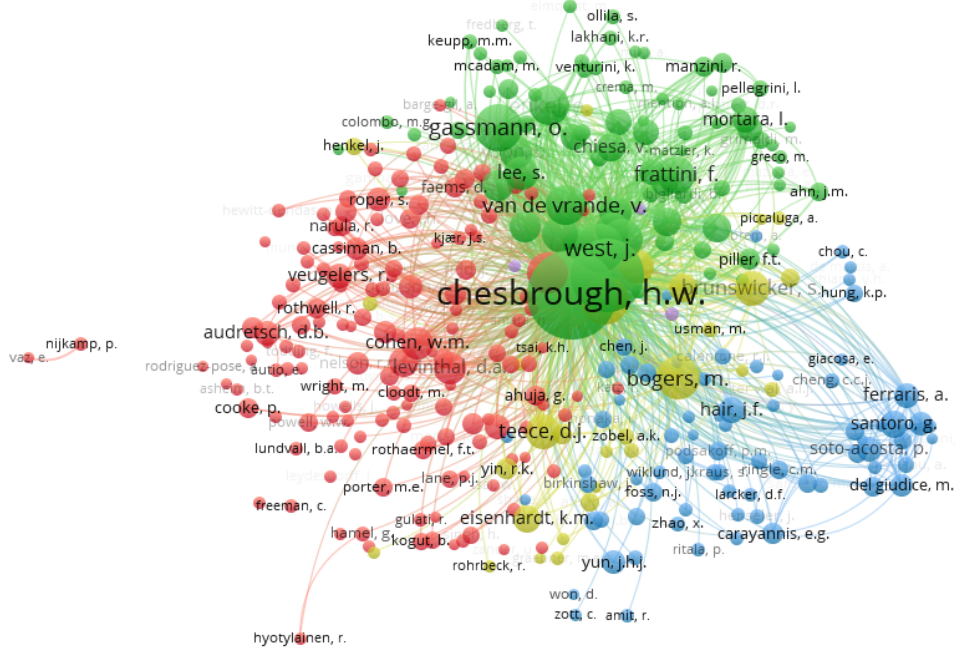
Figure 5. Visualization of author co-citation network.